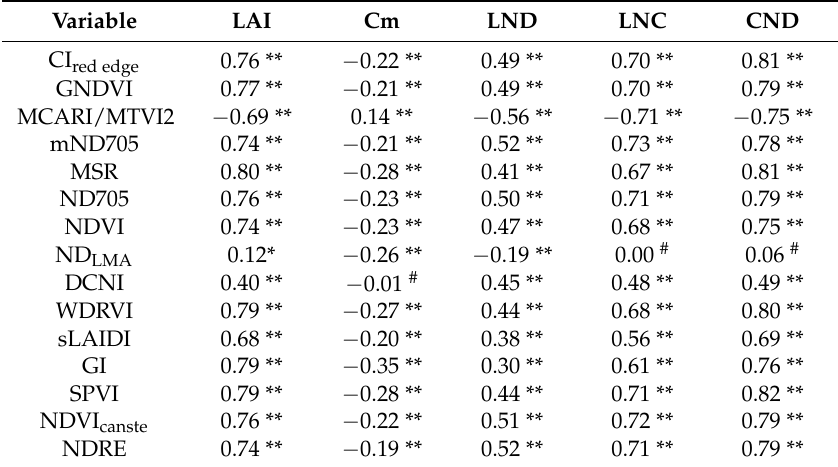
Table 6. Correlations between agronomic variables and vegetation indices ( n = 384).